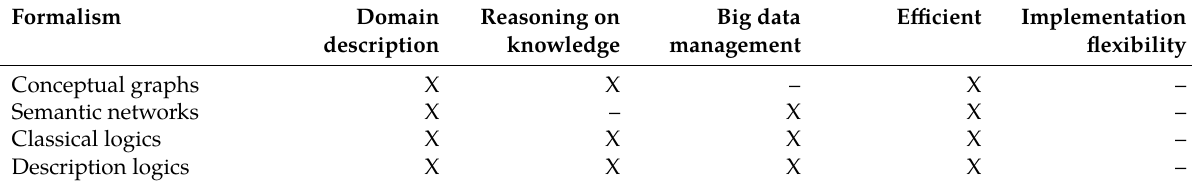
Reasoning on Big data Efficient Implementation description knowledge management flexibility